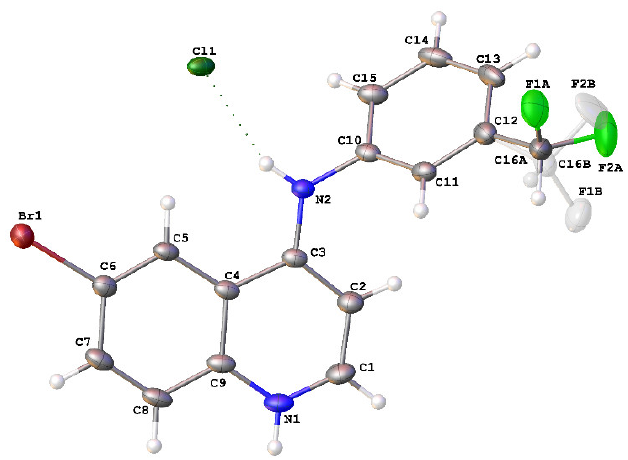
Figure 3. Molecular structure of 8 H + Cl − showing atomic labelling and displacement ellipsoids at 50% probability level. The difluromethyl minor disorder component is shown “ghosted”.